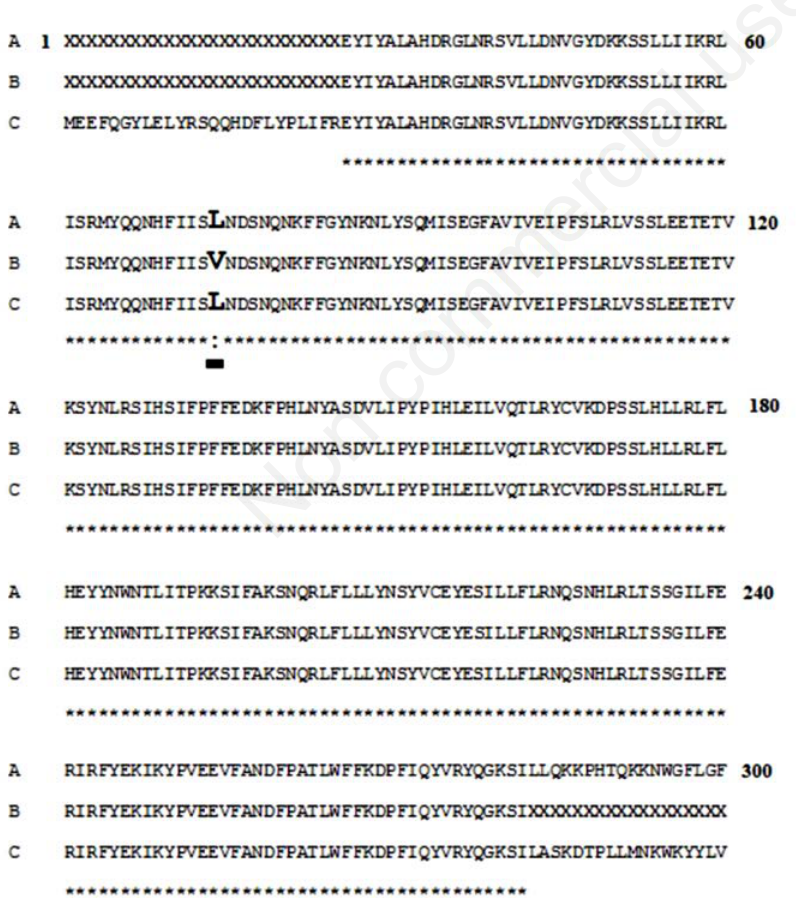
Figure 3. The aligned amino acid sequences for the two varieties of R. x damascena trig- intipetala [A] and [B] along with that of R. x damascena [C] found in Genbank database. The underlined letter showed the non-synonymous change in the variety [B]. Stars indi- cate sequence identity. The missed data from both varieties A and B are denoted by